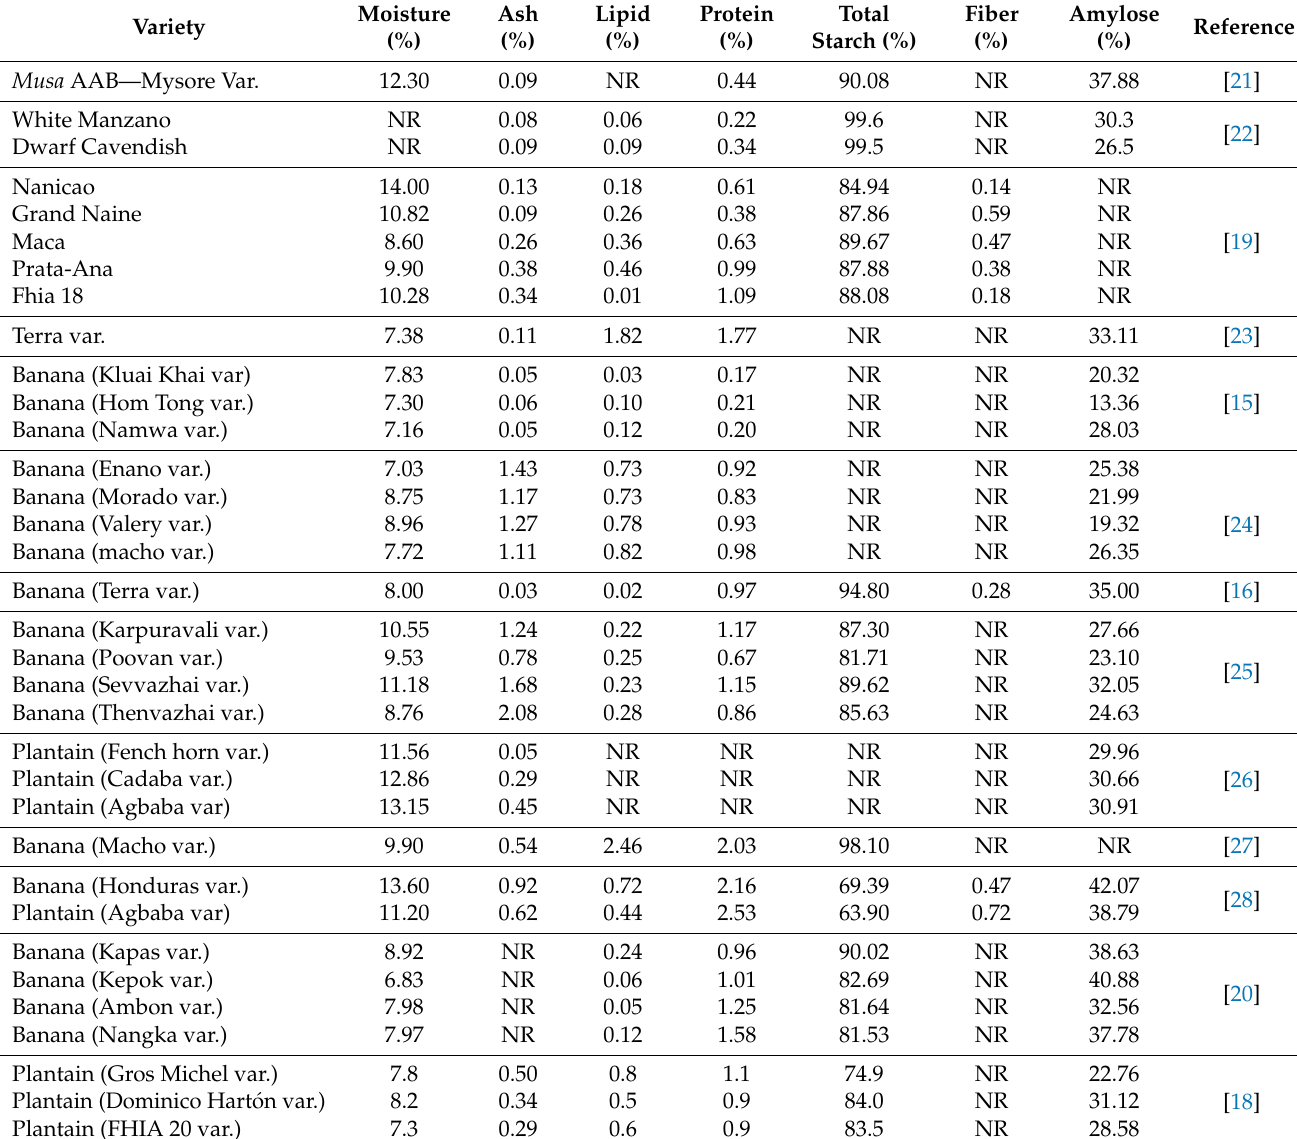
Table 1. Chemical composition of starches from various banana